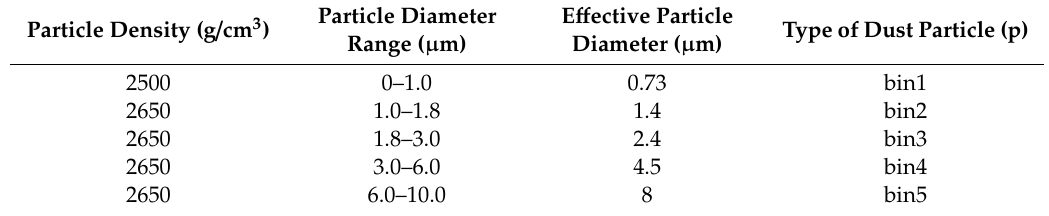
Table 4. Dust particle diameter distribution by category in WRF-Chem model.